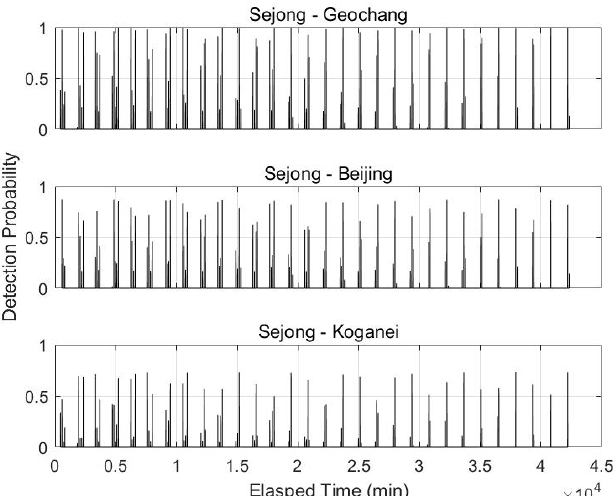
Figure 8. Time series of detection probability with 25 mJ energy at transmitting station (Sejong).